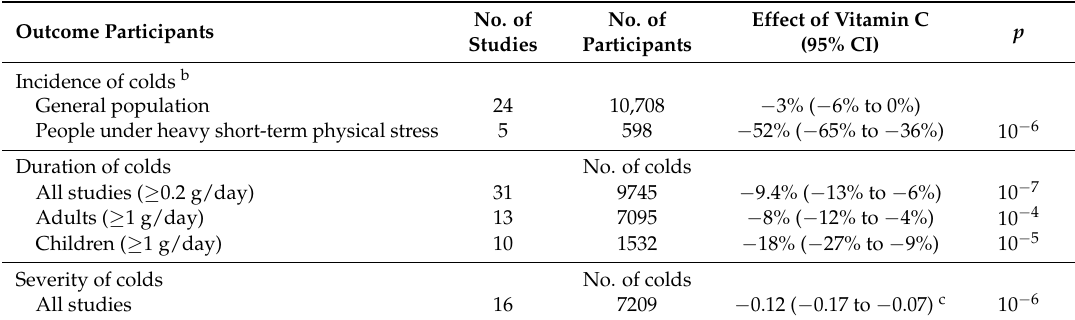
Table 4. Effects of regular vitamin C on the incidence and duration of the common cold a